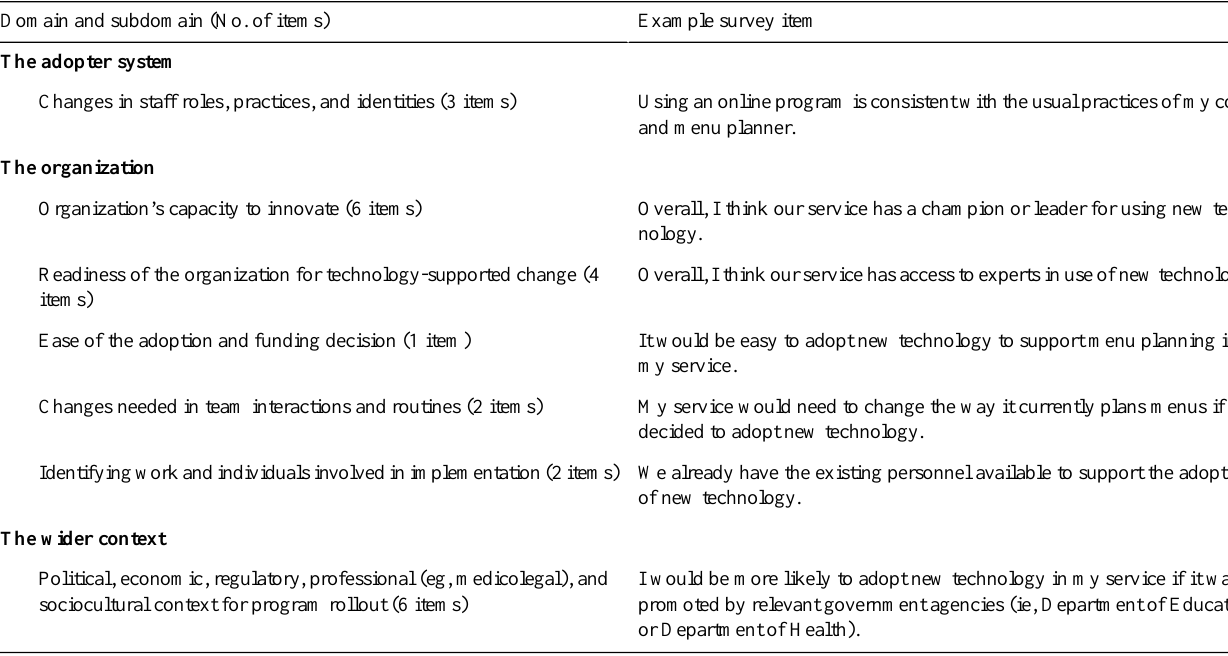
Table 1. Nonadoption, abandonment, scale-up, spread, and sustainability framework application to the early childhood education and care setting. The adopter system planner.Changes in staff roles, practices, and identities (3